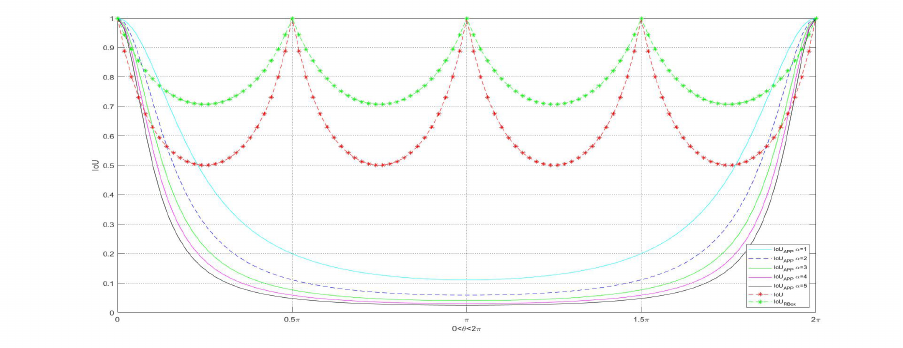
Figure 4. Relationship between IoU APP , IoU , and IoU RBox